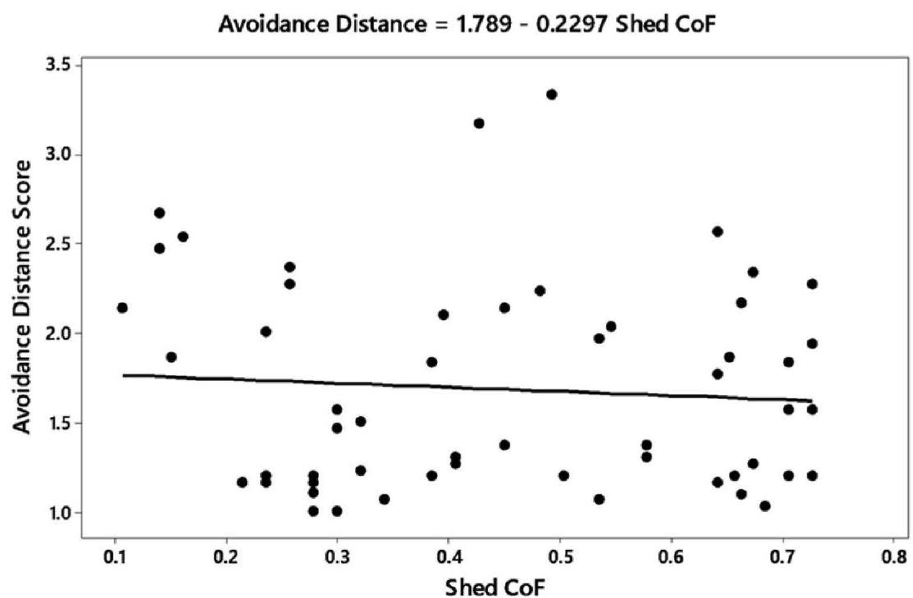
Figure 2. Relationship between the avoidance distance score and coefficient of friction (CoF) of shed floor.